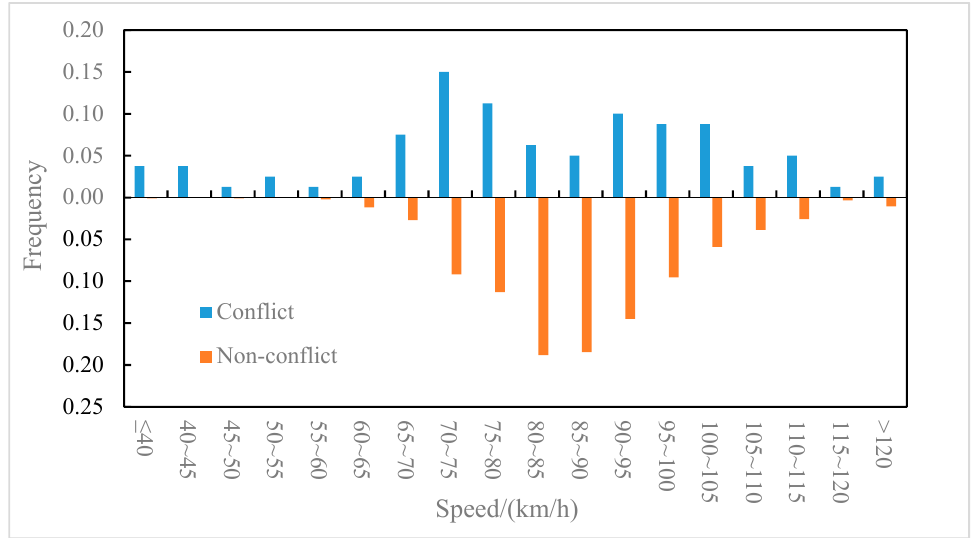
Figure 6. Outer lane—speed distribution of conflict events and non-conflict events.